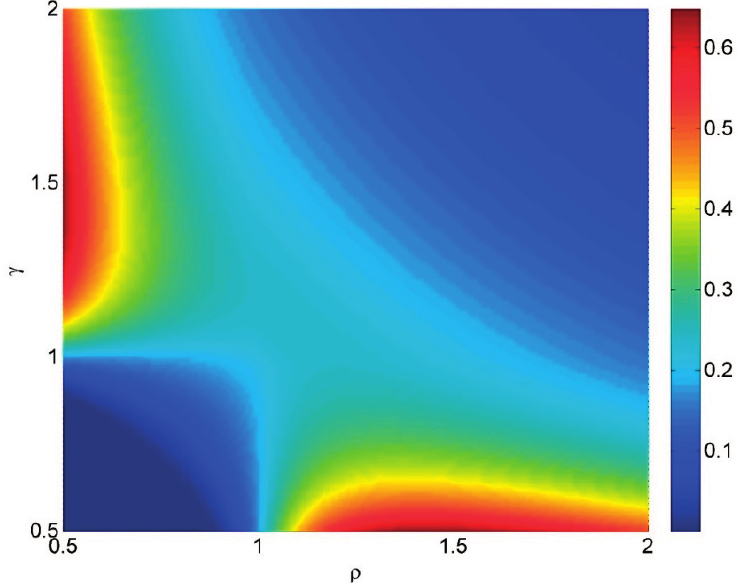
Figure 14. An illustration of a simple cost function applied to the targeting